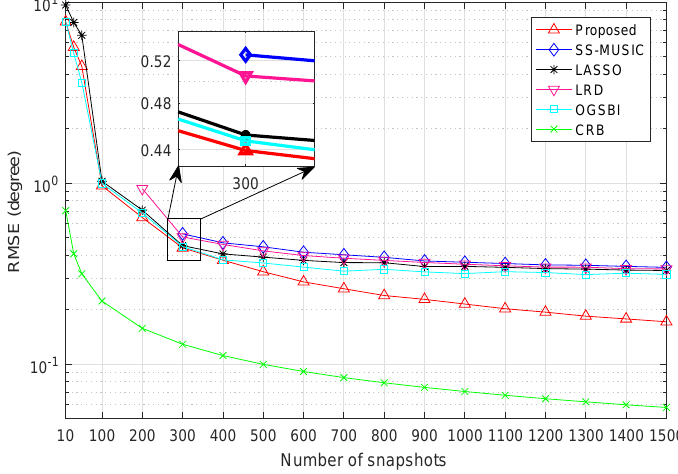
Figure 5. RMSE as a function of snapshots with SNR = 0